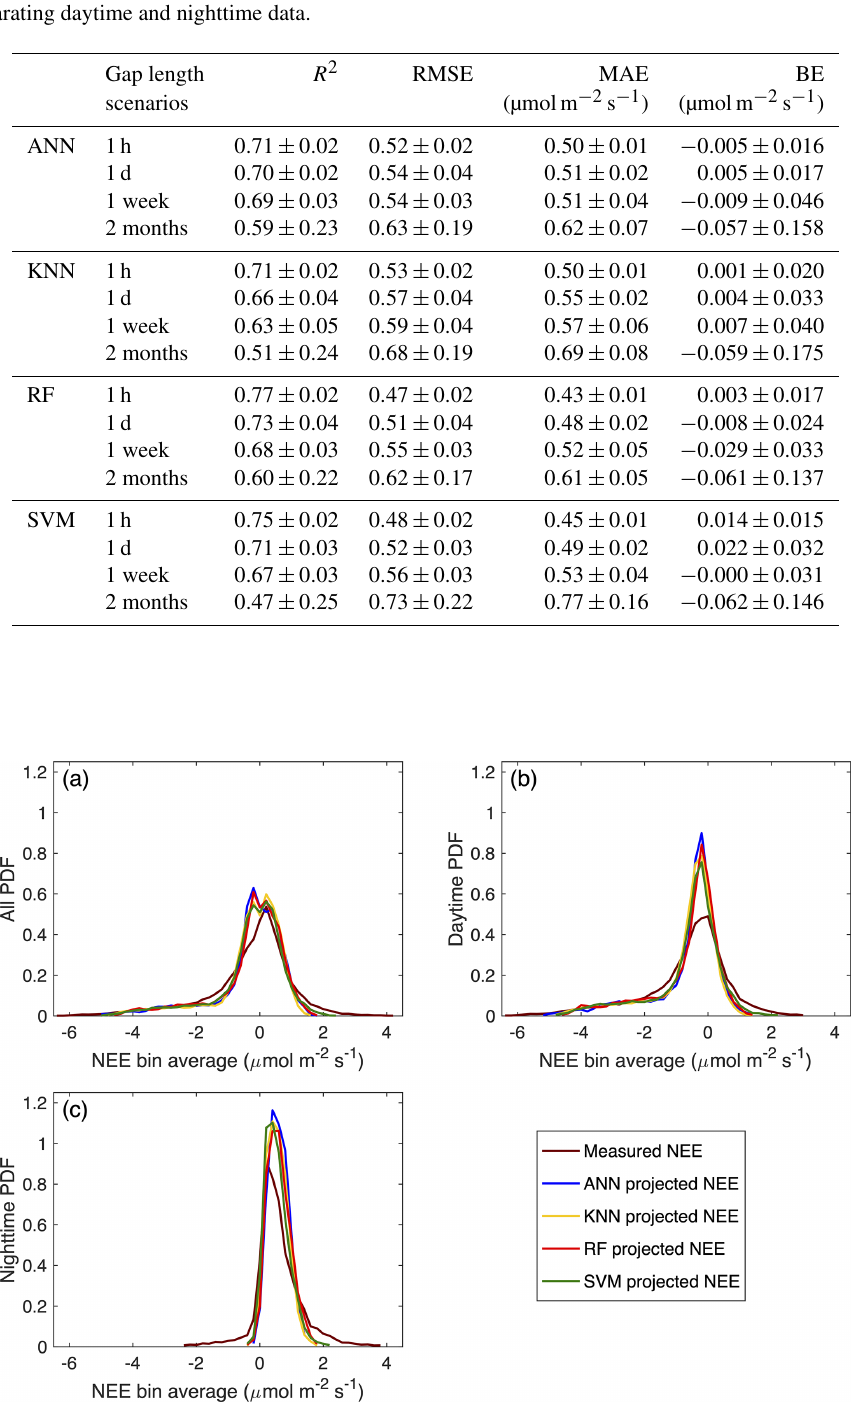
Figure 4. Comparison of probability density functions (PDFs) for the measured and estimated NEE of the gap-filling algorithms using daytime and nighttime data together and separately. The PDFs are estimated from the binned density distributions divided by the bin width. The bin width is 0.2µmolm − 2 s − 1 , and bins with fewer than 10 data points are